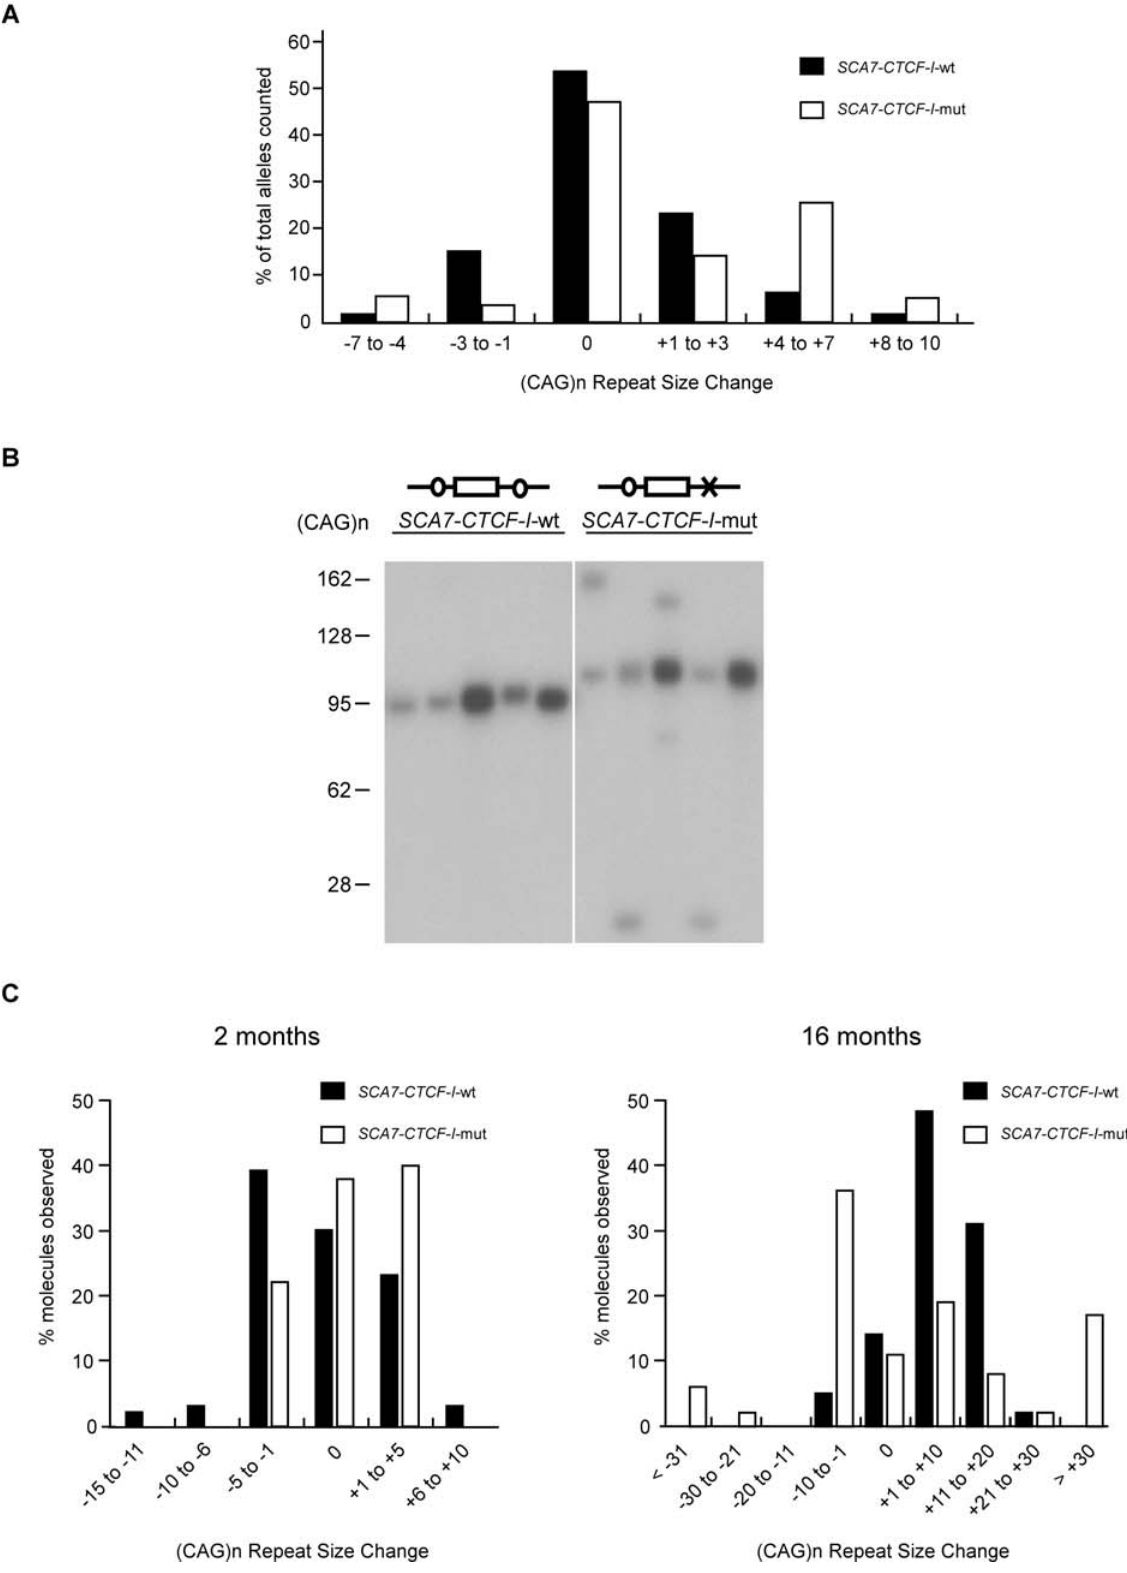
Figure 2. SCA7-CTCF-I -mut mice display increased germ line instability. (A) Comparison of CAG repeat instability in parent-offspring transmissions for SCA7-CTCF-I mice. Repeat lengths are plotted as % of total alleles scored for 53 SCA7-CTCF-I -wt and 95 SCA7-CTCF-I -mut mice. The repeat size range in the SCA7-CTCF-I -mut mice was significantly different from the distribution of repeat alleles in the SCA7-CTCF-I -wt mice (p=0.002; Mann-Whitney two-tailed test). (B) Small-pool PCR of sperm DNAs in 16 month-old SCA7 transgenic mice. SCA7-CTCF-I -wt mice typically exhibited small repeat length changes, while SCA7-CTCF-I -mut mice displayed pronounced instability. (C) Compilation of small-pool PCR data. At 2 months of age, only modest instability was noted. At 16 months of age, SCA7-CTCF-I -wt mice displayed moderate instability, but SCA7-CTCF-I -mut mice exhibited significantly greater instability (p=0.009; Mann-Whitney two-tailed test). doi:10.1371/journal.pgen.1000257.g002 PLoS Genetics | www.plosgenetics.org